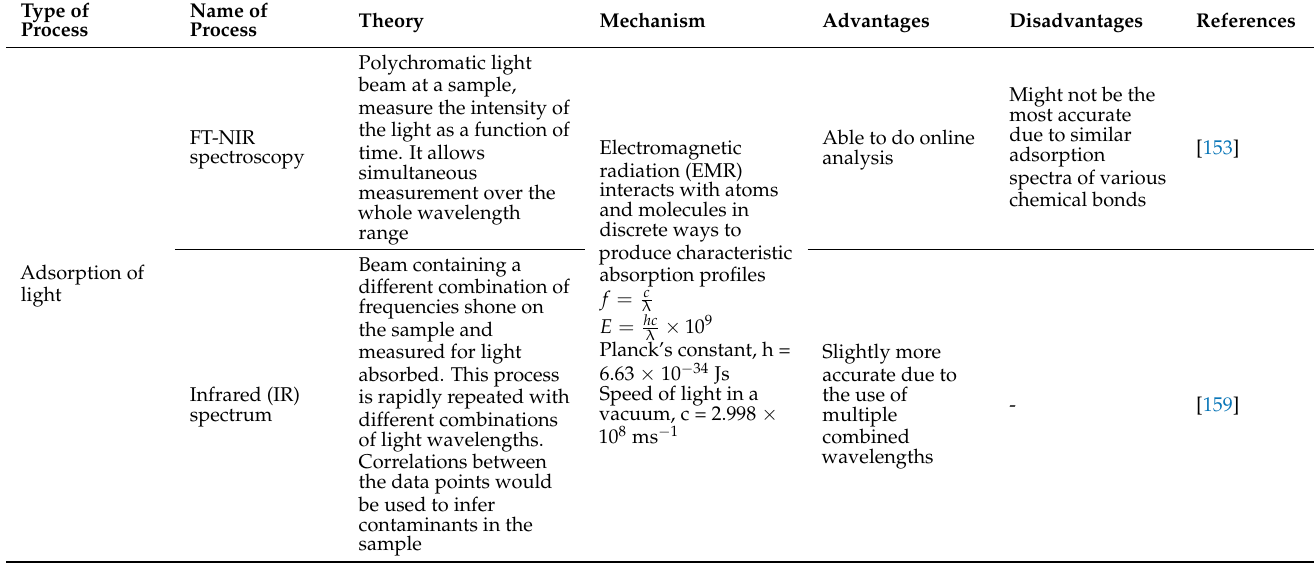
Table 8. Evaluation of light-driven technology for the detection and management of